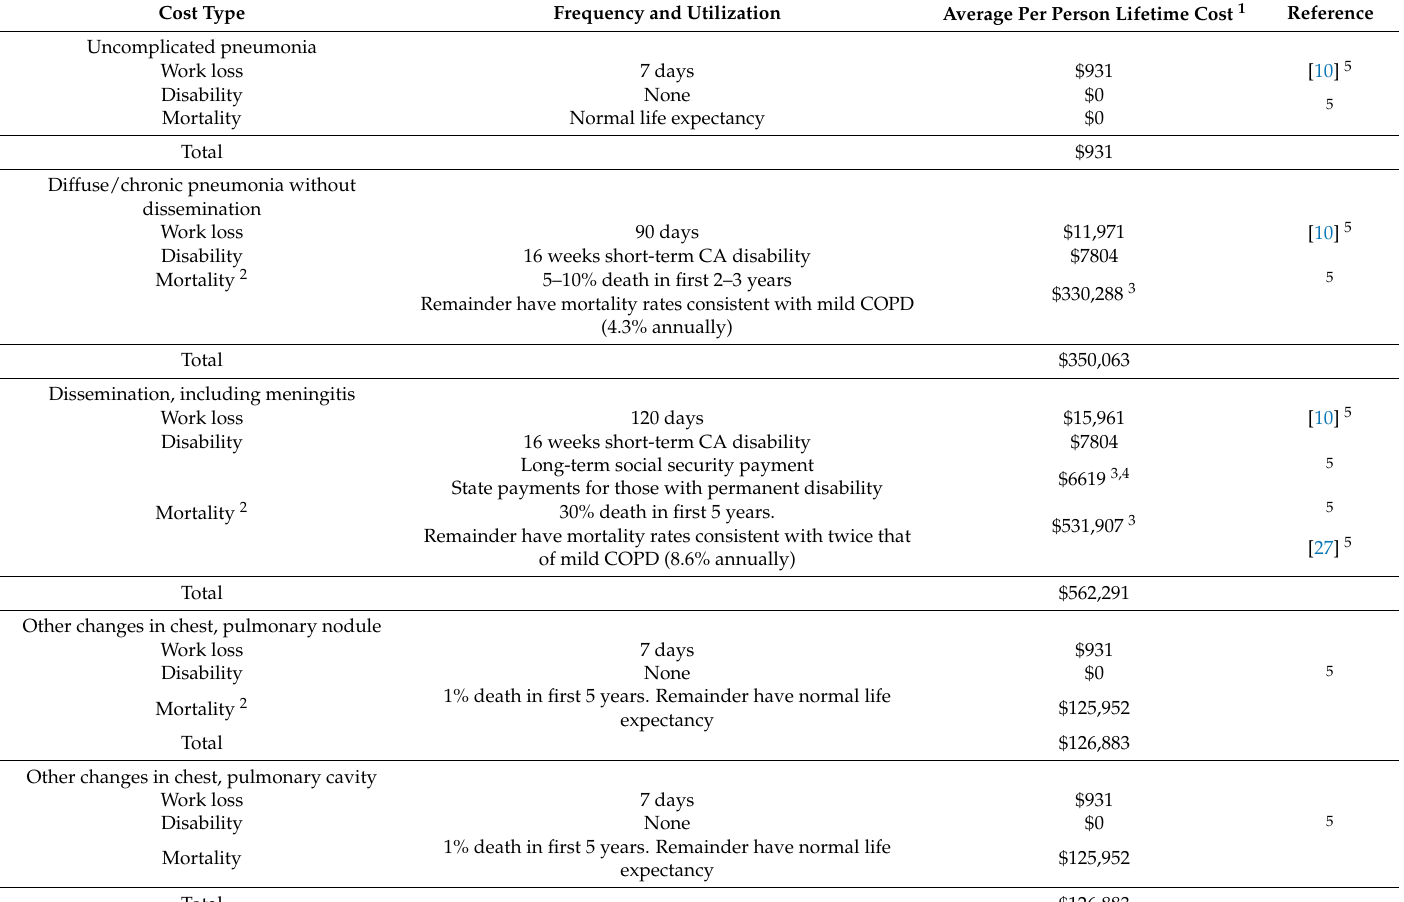
Table 3. Estimated indirect lifetime costs per person, stratified by types of costs and coccidioidomycosis (CM) disease manifestation in